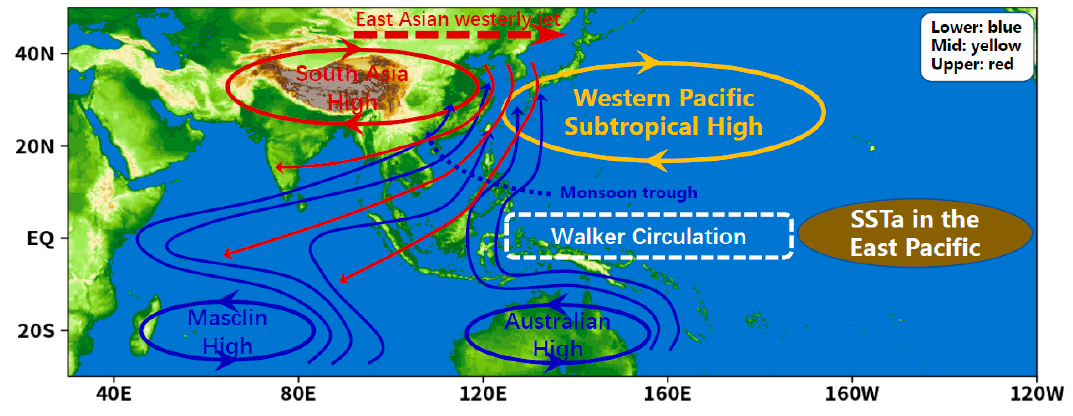
Figure 1. The schematic diagram of monsoon systems.